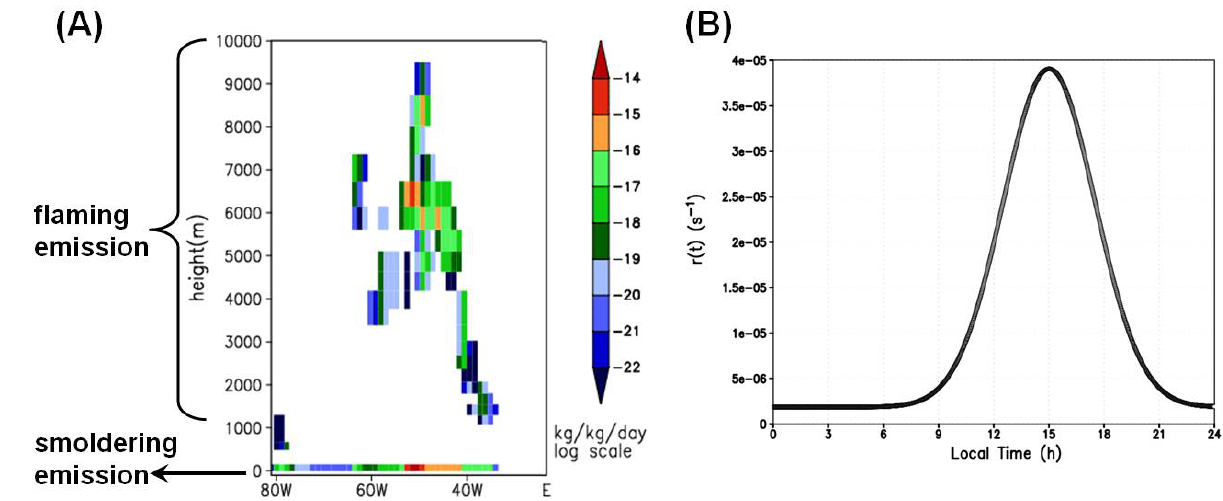
Fig. 3. (A) An example of a simulated vertical cross section of biomass burning CO source emission on 18:00UTC 02 September 2002 at latitude 5.4 ◦ S (adapted from Freitas et al., 2007). It shows the surface emission associated to the smoldering phase as well as elevated emission layers associated to the flaming phase. The panel (B) depicts a Gaussian function centered at 15:00LT used to determine the diurnal cycle of biomass burning emissions on South America.